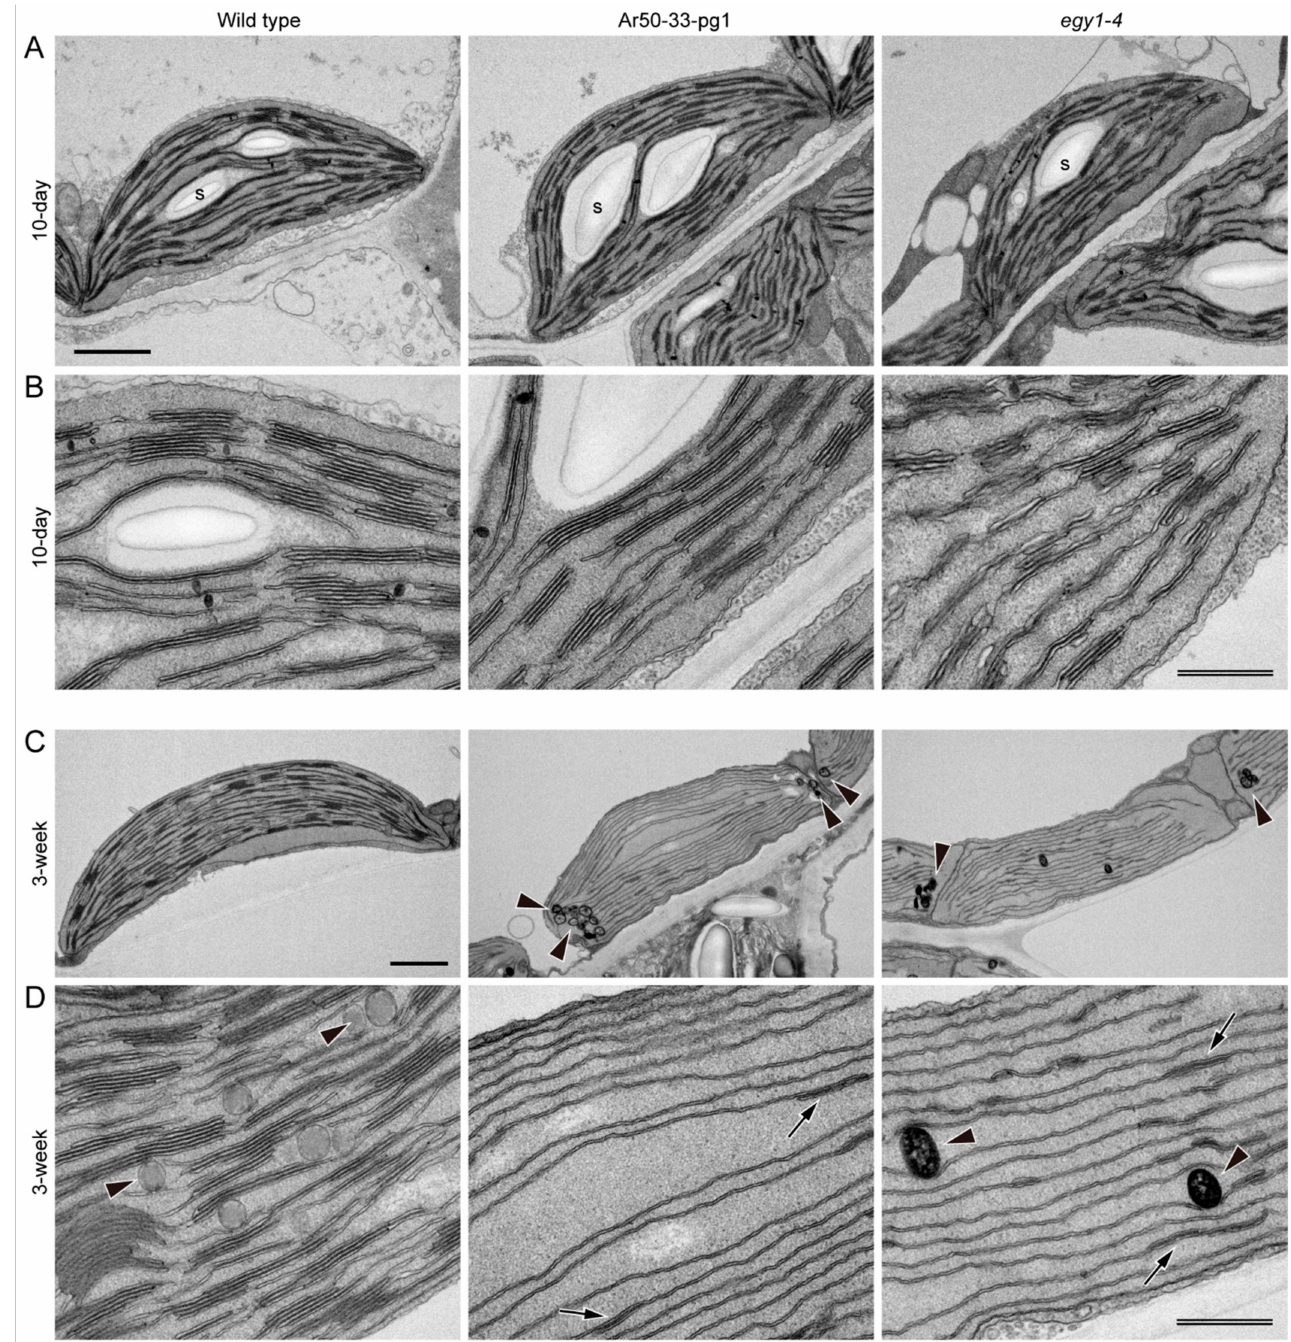
Figure 8. Ultrastructural analysis of mesophyll chloroplasts in wild type and mutant plants. Mesophyll cells of 10-day- and 3-week-old wild type, Ar50-33-pg1, and egy1-4 plants analyzed by transmission electron microscopy. ( A , B ) Ten-day-old plants. ( C , D ) Three-week-old plants. Arrowheads and arrows indicate plastoglobules and short attachment sites between thylakoids, respectively. Abbreviation: s, starch grain. Bar = 1 µ m (single) and 500 nm